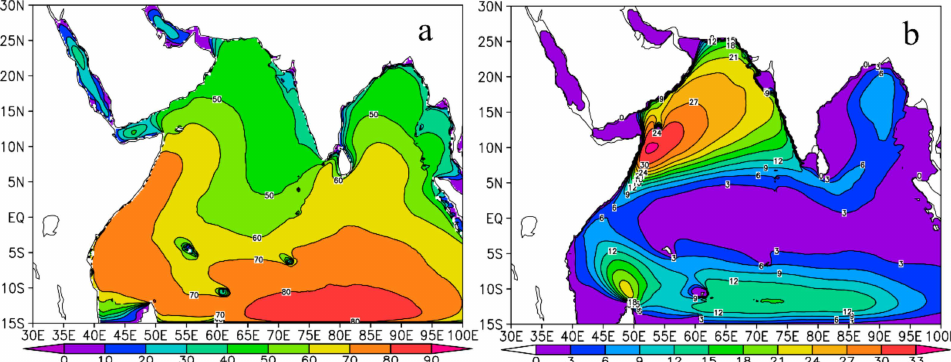
Figure 8. Occurrence of annual average wave energy density larger than 2 KW / m (unit: %) ( a ) and wave energy density larger than 20 KW / m (unit: %) ( b